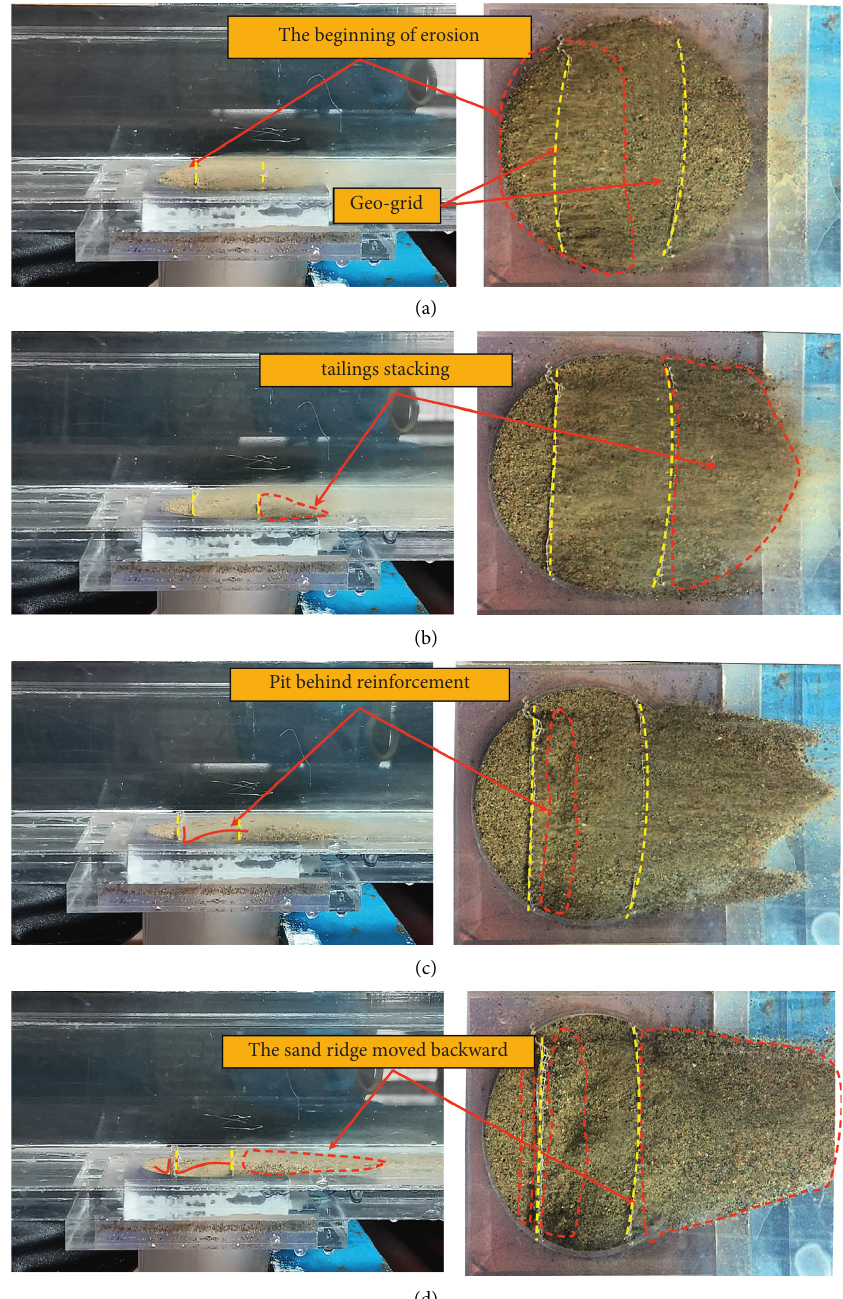
Figure 5: Tailings erosion phenomena with different geogrid spacing. (a) The front end of the sample begins to erode. (b) The front end of the sample is flushed, and the tailings behind the second layer of reinforcement are stacked. (c) Concavity of tailings behind the first layer of the band. (d) Backward movement of tailings ridge behind the second